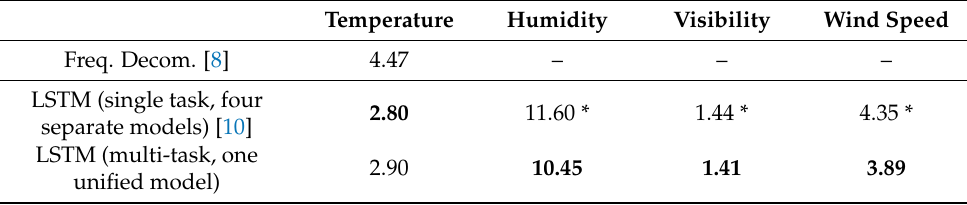
Table 3. Performance comparison between single-task LSTM and multi-task LSTM for day-wise weather property prediction, in terms of RMSE. *: Our previous work [10] only focused on temperature prediction, and here we trained dedicated models for humidity, visibility, and wind speed prediction.